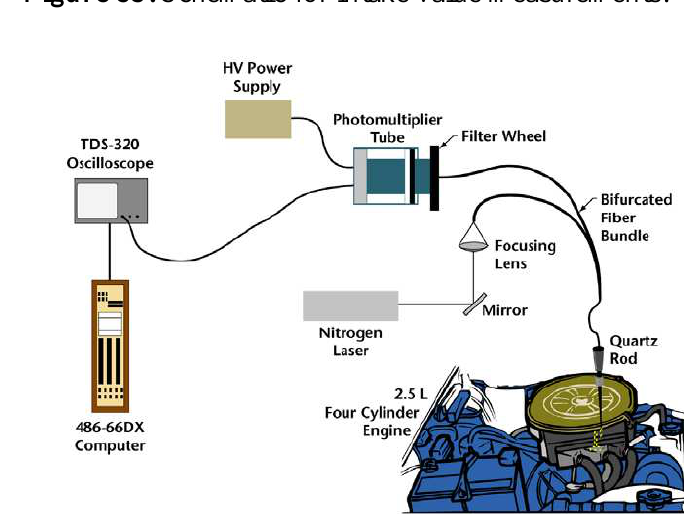
Figure 53. Schematic for intake value